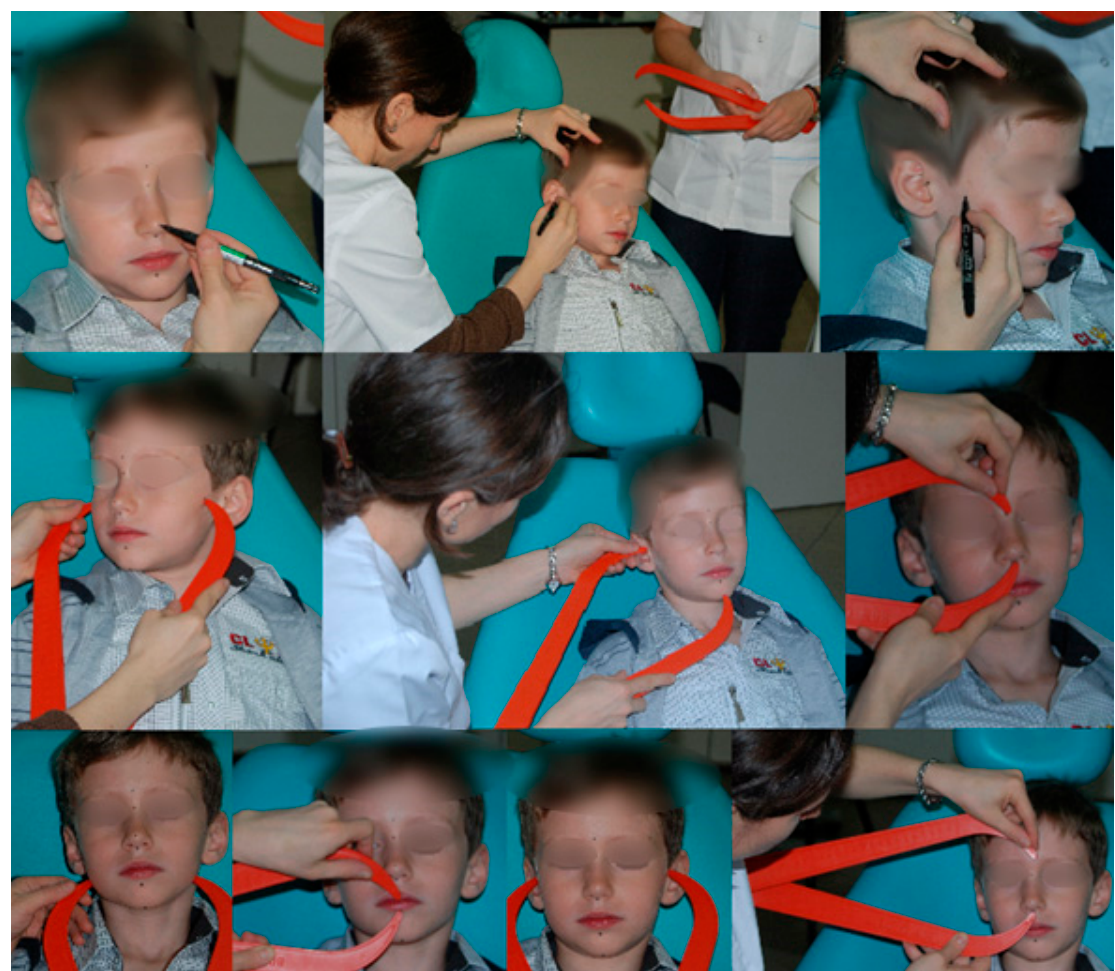
Figure 4. The simplified anthropometric technique used for the facial